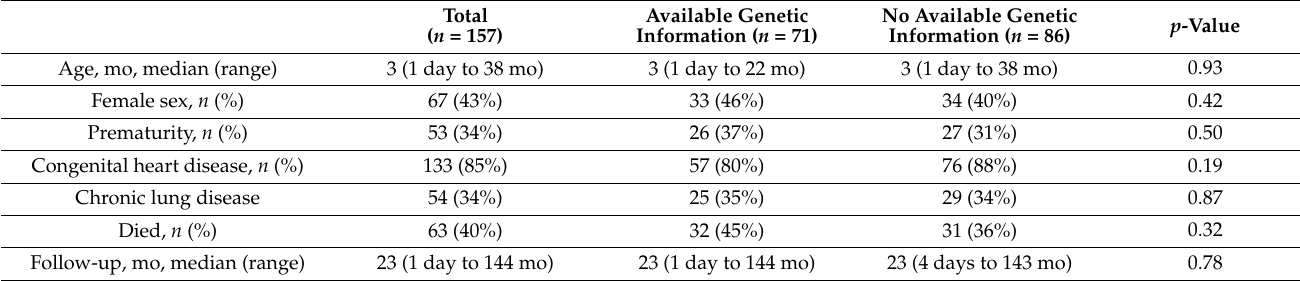
Figure 1. Available genetic testing results in patients with pulmonary vein stenosis (PVS). The genetic results of patients with known pathogenic variants are shown. Abbreviations: SLO, Smith–Lemli–Opitz syndrome. Table 1. General characteristics of patients with PVS and comparison of patients with and without available genetic information ( n =